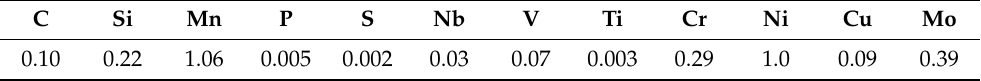
Table 1. Chemical composition of the X80 heavy-wall heat-induced seamless bend (wt%). C Si Mn P S Nb V Ti Cr Ni Cu Mo 0.10